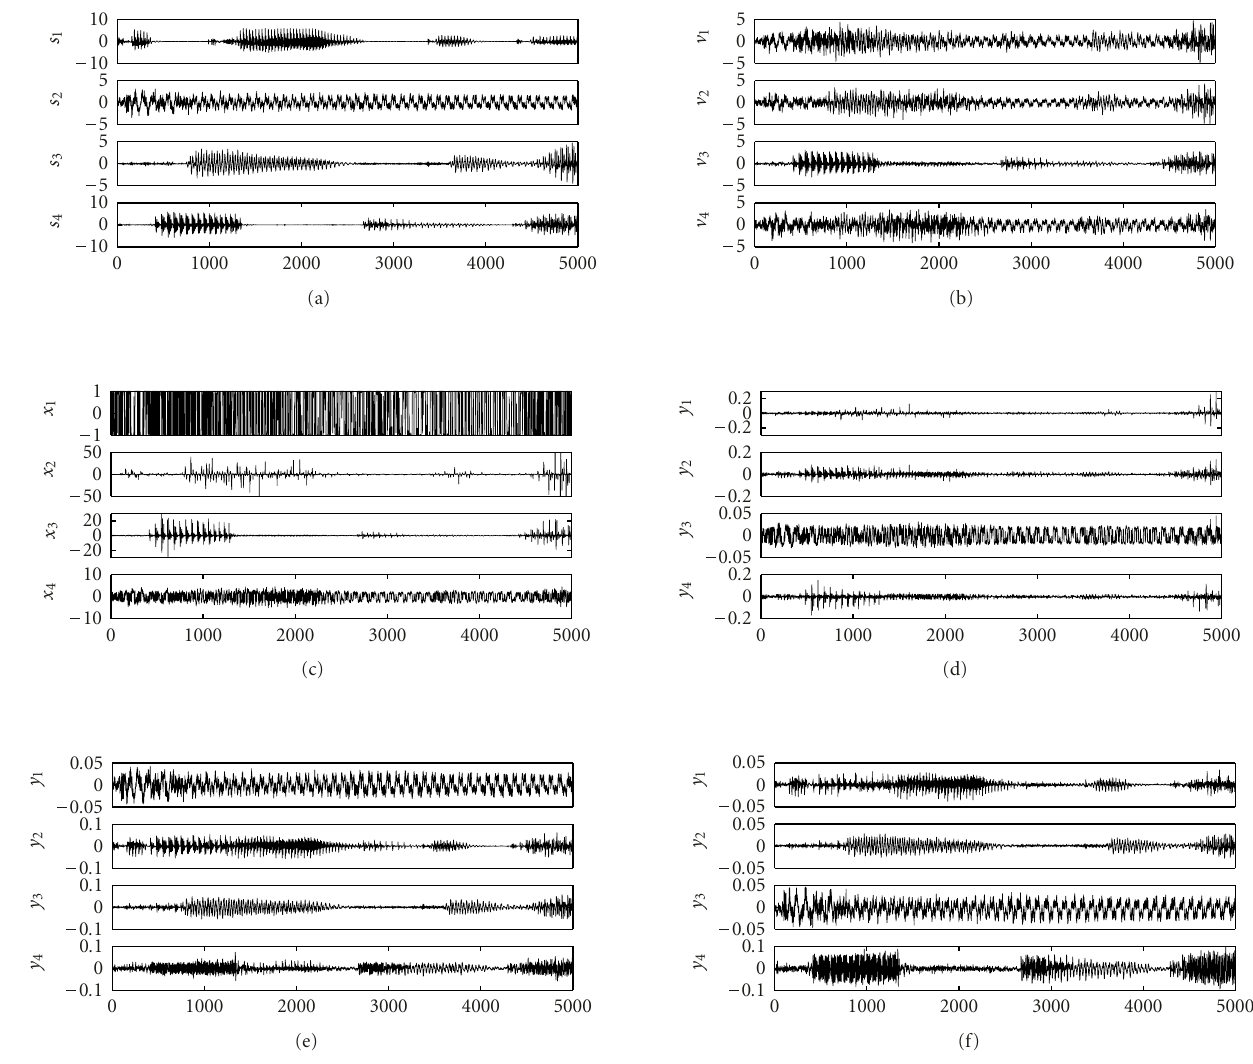
Figure 11: Plots of the speech signals. (a) Unknown sources. (b) Linear mixtures. (c) PNL mixtures. (d) SOBI estimates. (e) Gauss-TD estimates. (f) gpICA